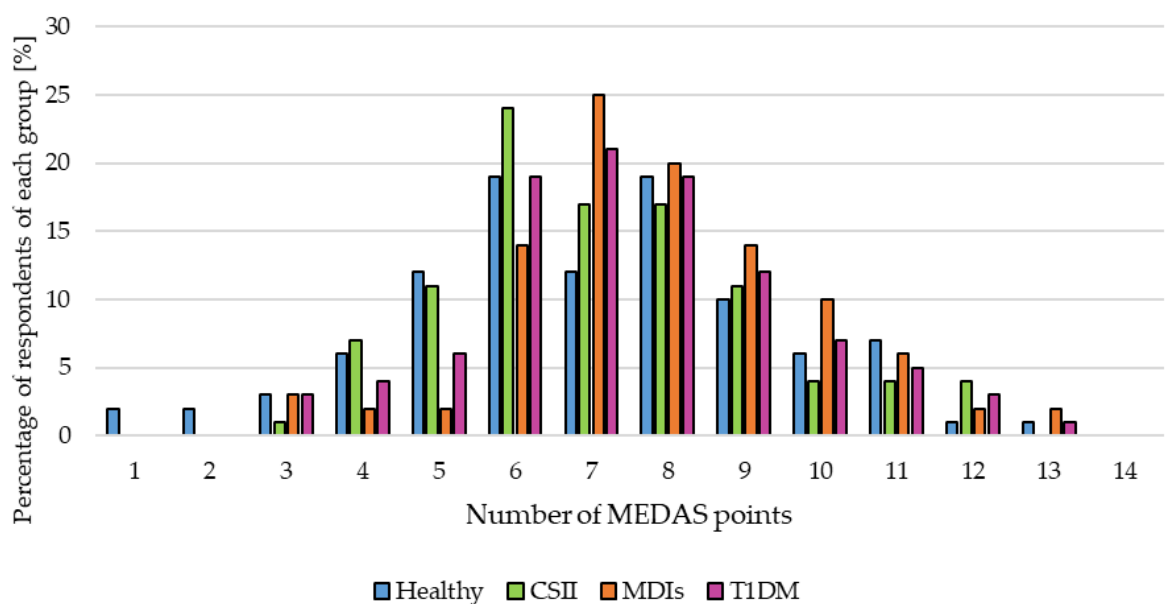
Figure 4. Adherence to the Mediterranean diet in the study cohort. Abbreviations: continuous subcutaneous insulin infusion (CSII), multiple daily injections (MDIs), Mediterranean Diet Adherence Screener (MEDAS), type 1 diabetes mellitus (T1DM).